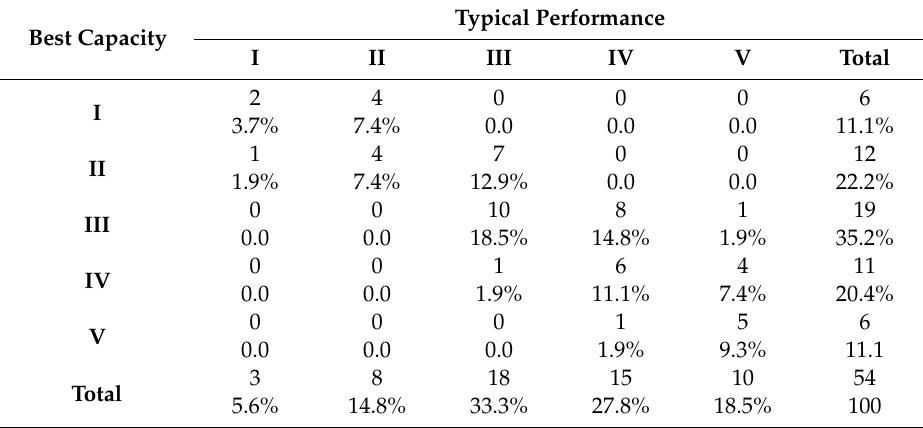
Table 2. Autism Classification System of Functioning: Social Communication (ACSF:SC) best capacity and typical performance ratings. Agreement between best capacity and typical performance is highlighted. Typical Performance Best Capacity